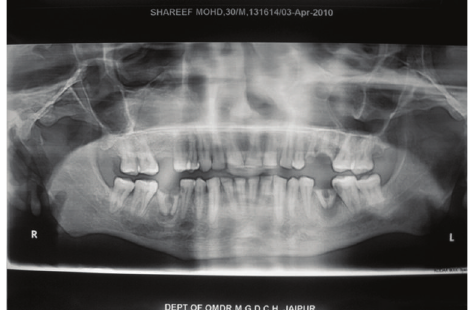
Figure 4: IOPA radiograph of maxillary right posterior region showing a partial radiolucency superimposed on the edentulous region.